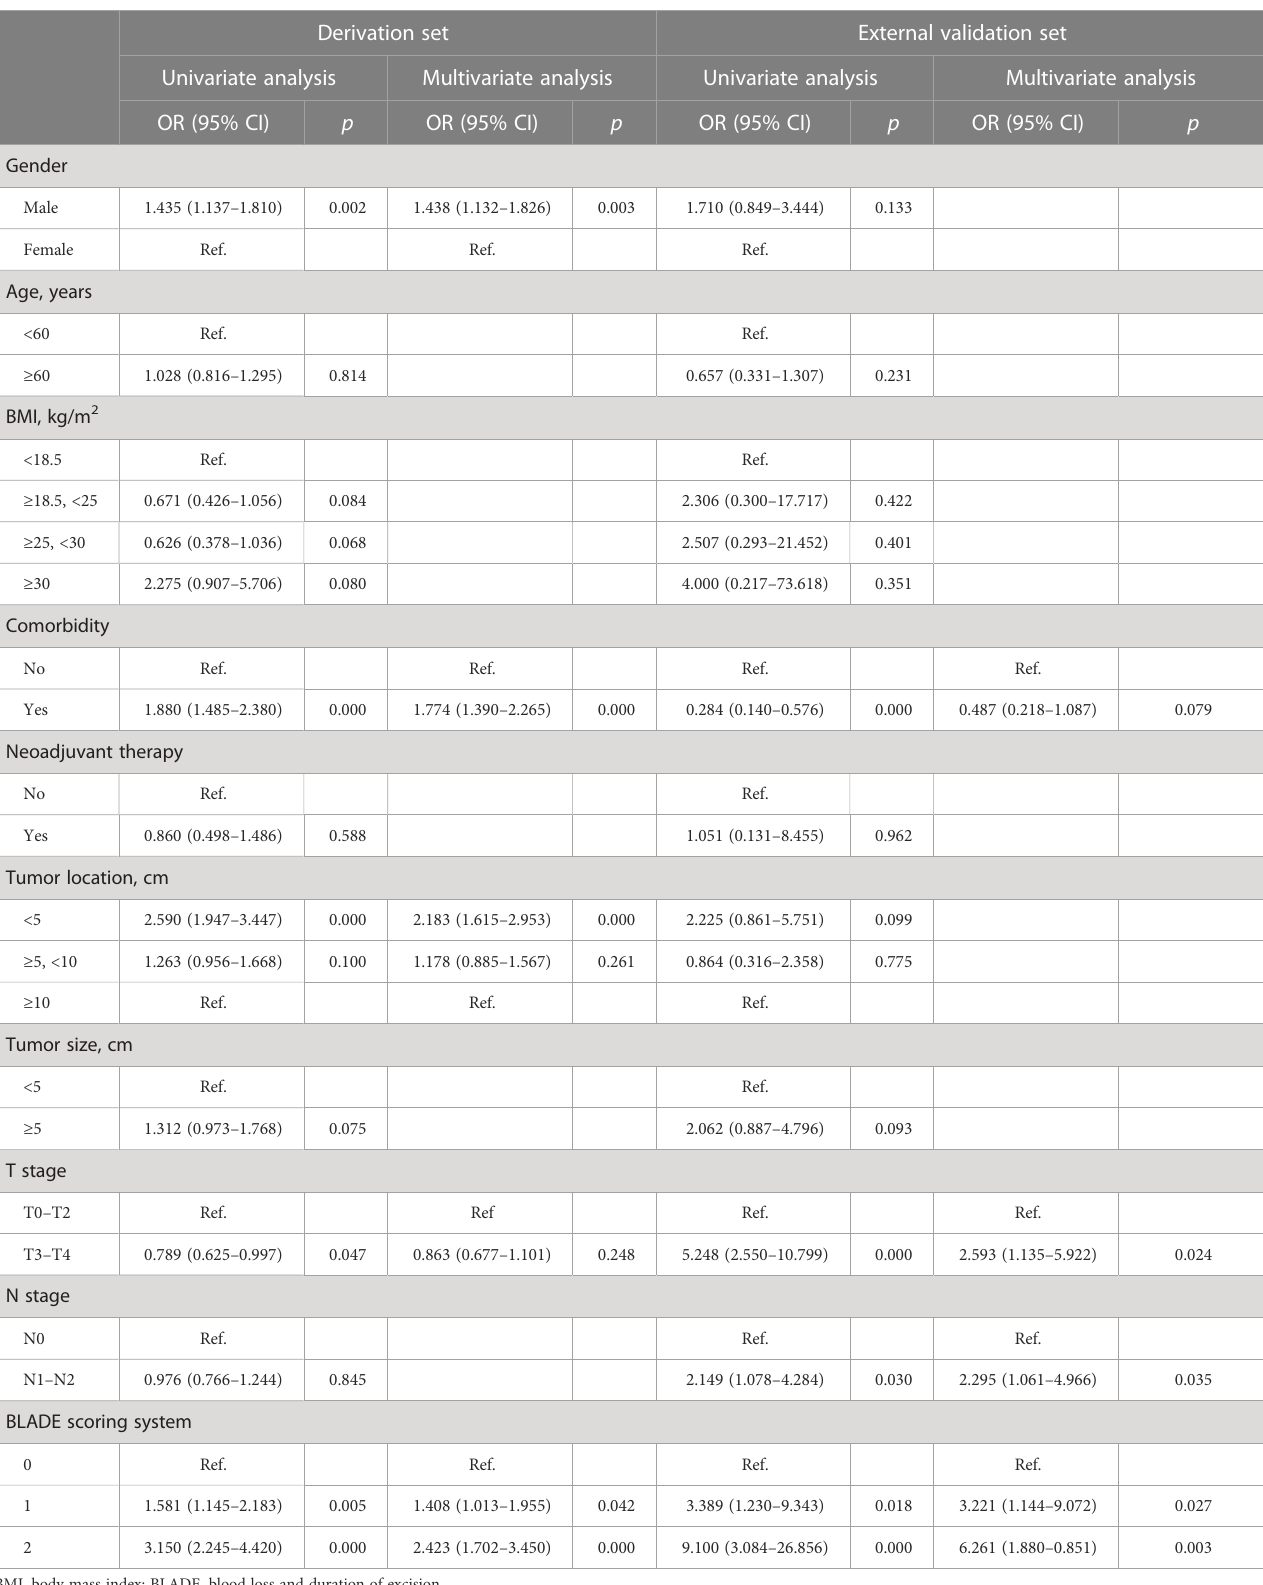
TABLE 3 Univariate and multivariate logistic regression analyses of postoperative